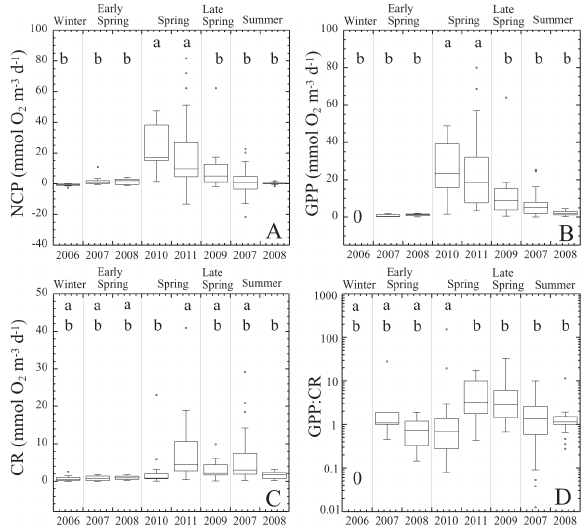
Fig. 3. Box plots showing the distribution of metabolic rates for the different cruises presented here: (A) net community production (NCP), (B) gross primary production (GPP), (C) community respi- ration (CR) rates and (D) the ratio of GPP to CR. All rates reported inmmolO 2 m − 3 d − 1 . The boxes show the median of the metabolic rates plus the lower (25%) and upper (75%) quartiles, the whiskers indicate 1.5 times the Interquartile Range (IQR). Letters indicate the results for a Tukey HSD (honestly significant difference) test, whereby the metabolic rate did not differ significantly for cruises with the same